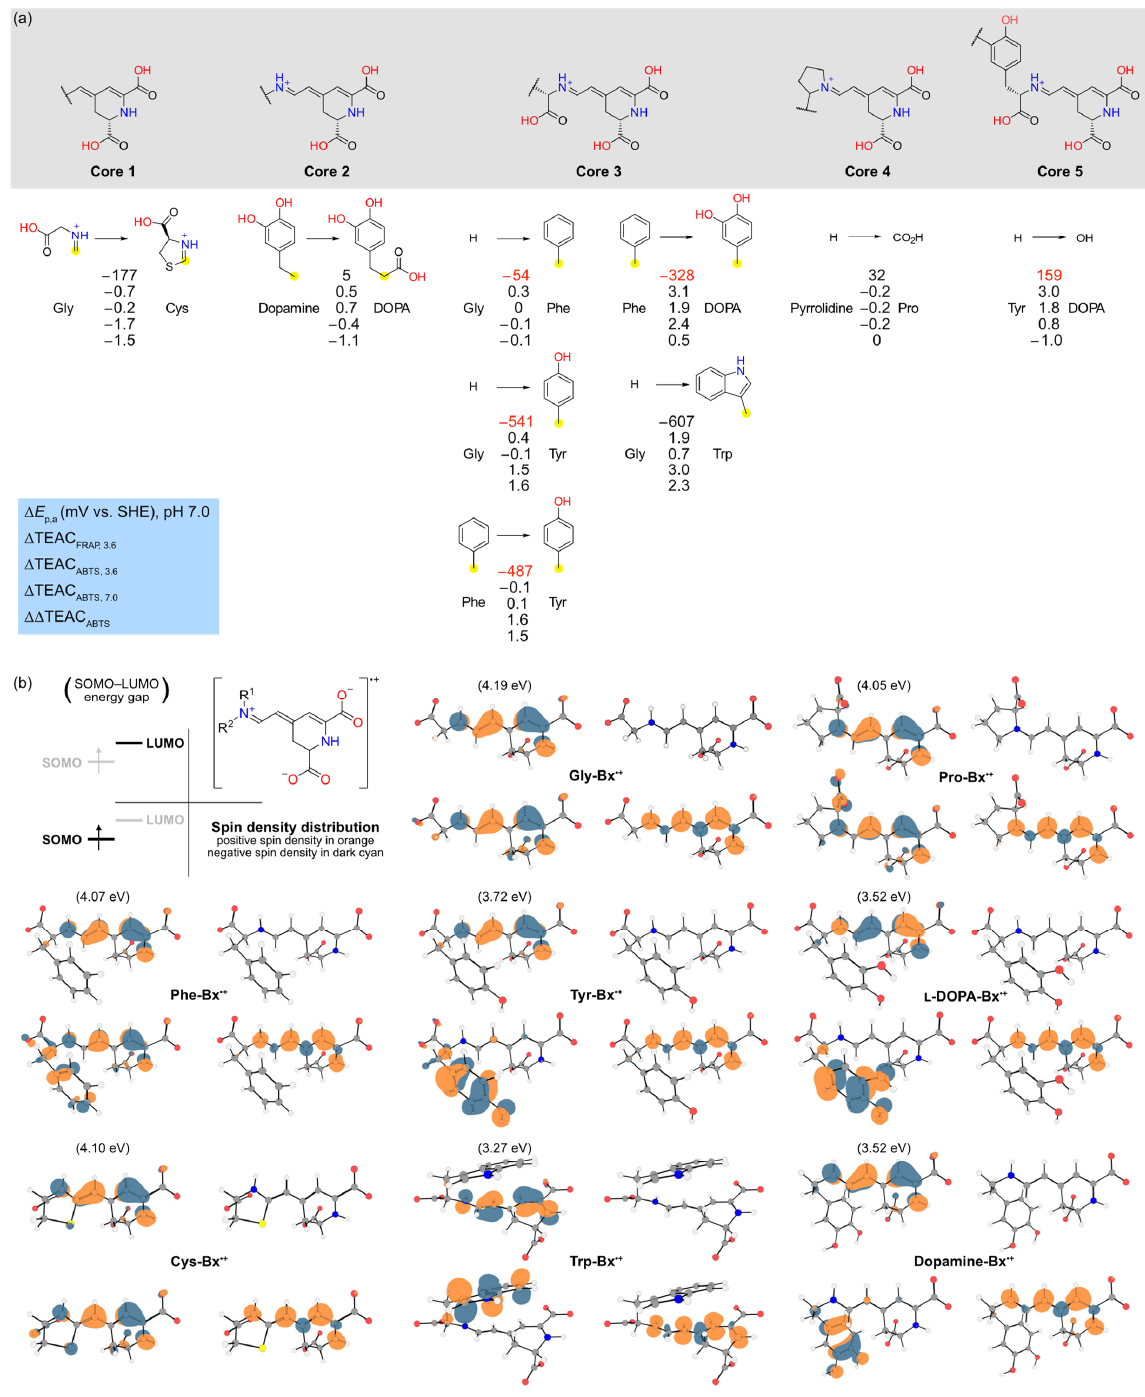
Figure 6. Matched molecular pair analysis (MMPA) and quantum chemical calculations. ( a ) MMPA with five cores and a single cut; attachment points with open valence are highlighted in yellow. Numbers are the experimental parameters indicated in the blue legend. ( b ) Structure, spin density distribution (isovalue 0.005) and frontier molecular orbitals (isovalue 0.05) of the radical cations of selected betaxanthins (doublets, referred to as radical cations for simplicity since the formal charge varies). Description of values and surfaces are presented in the legend in the up-left corner.